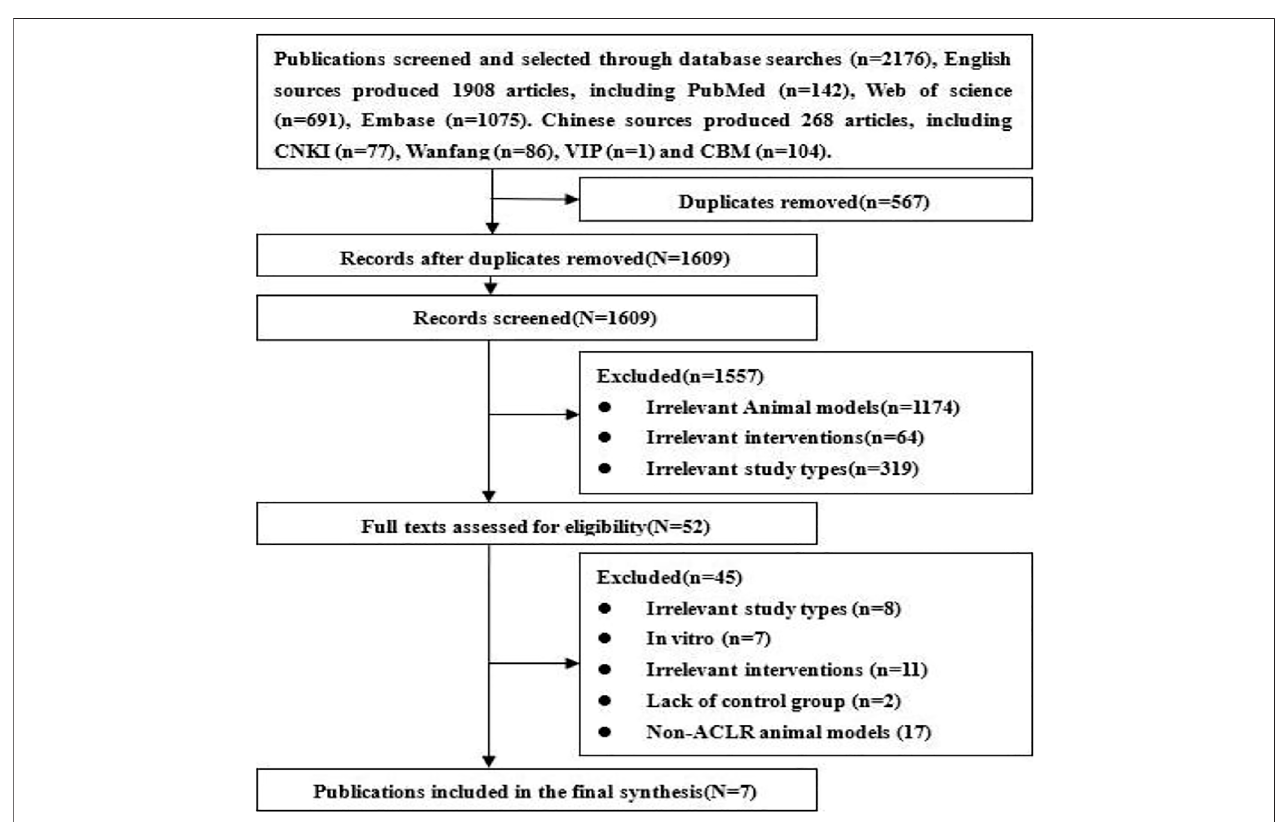
FIGURE 1 | Flowchart of the literature-screening